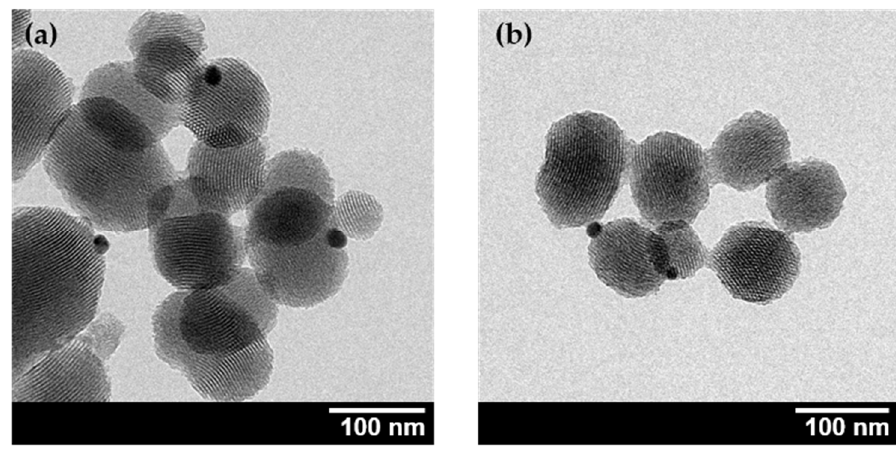
Figure 1. TEM images of NT-Ag ( a ) and NT-Ag@Ph ( b ).